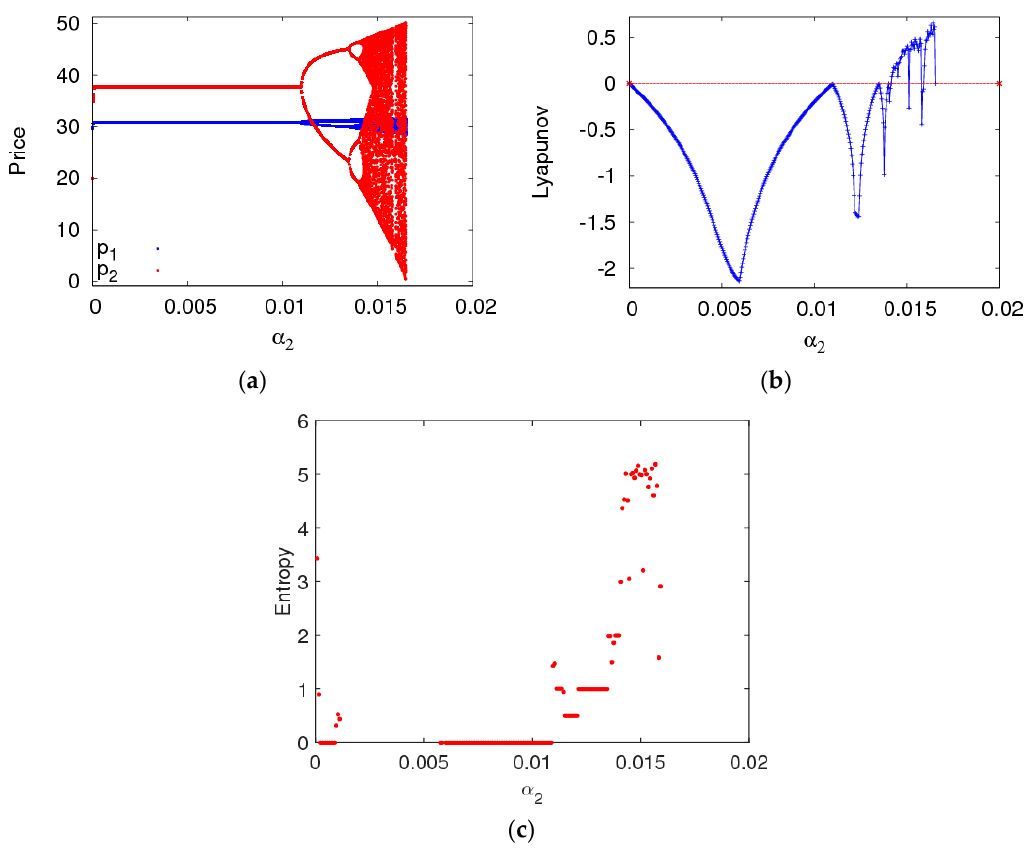
Figure 6. The behaviors of the dynamic system (6) with respect to α 2 and α 1 = 0.005. ( a ) The bifurcation diagram, ( b ) The LLE diagram, ( c ) The entropy diagram.